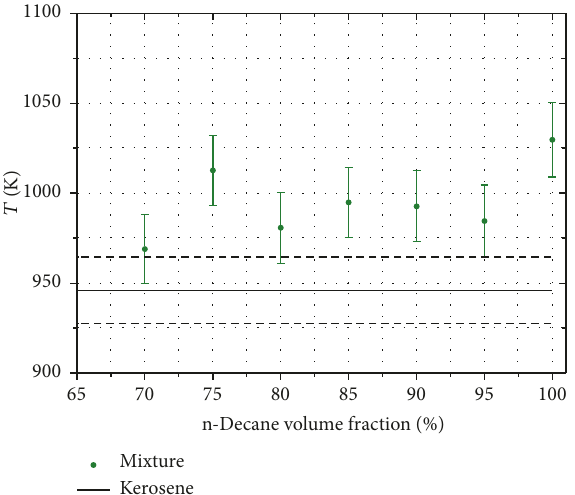
Figure 12: Comparison of averaging the temperature for the surrogate and the kerosene